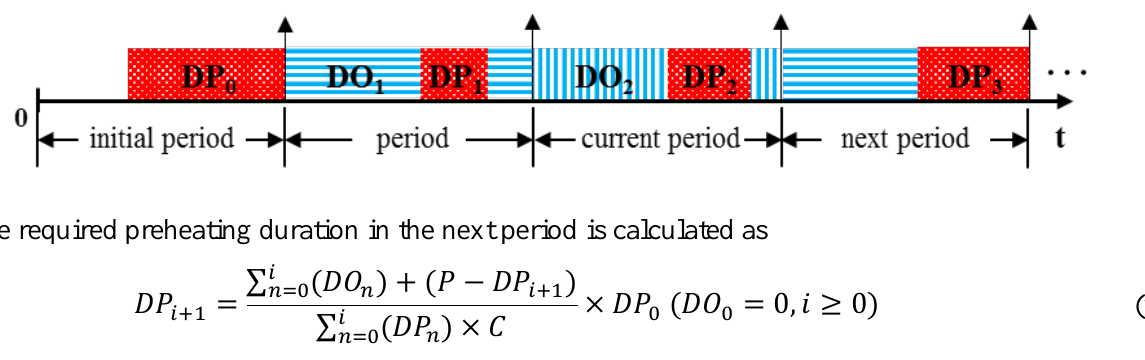
Figure 3. Power supply and cutoff durations of